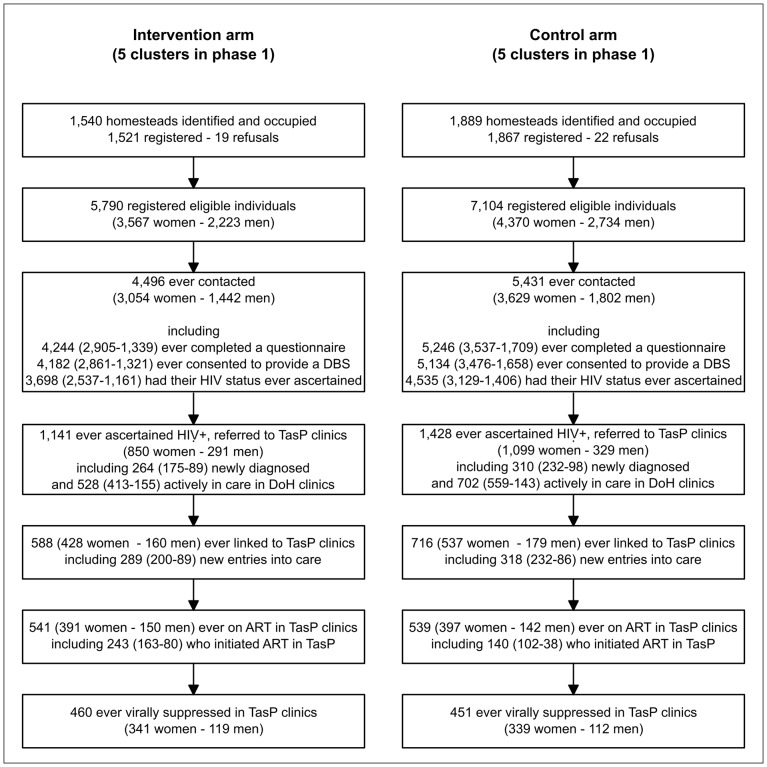
Flow diagram of enrolment by trial arm and sex in the ANRS 12249 TasP trial.